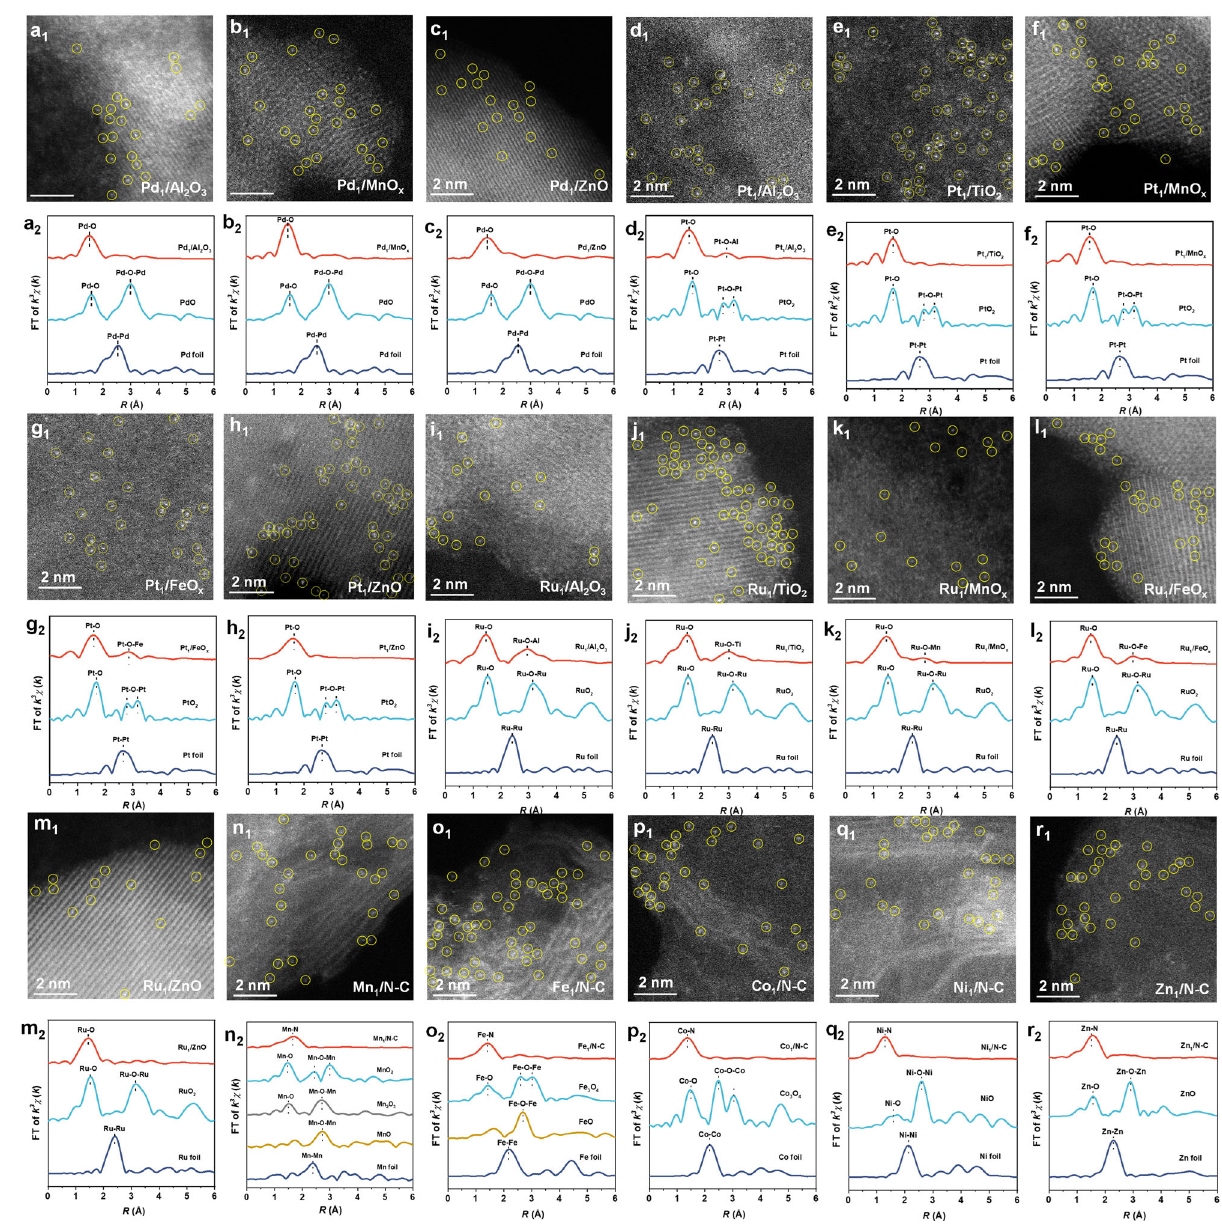
Fig.2|Theuniversalityoftheprecursor-atomizationstrategy.a 1 – r 1 ACHAADF- STEM images ofPd 1 /Al 2 O 3 ( a 1 ),Pd 1 /MnO x ( b 1 ), Pd 1 /ZnO ( c 1 ), Pt 1 /Al 2 O 3 ( d 1 ),Pt 1 /TiO